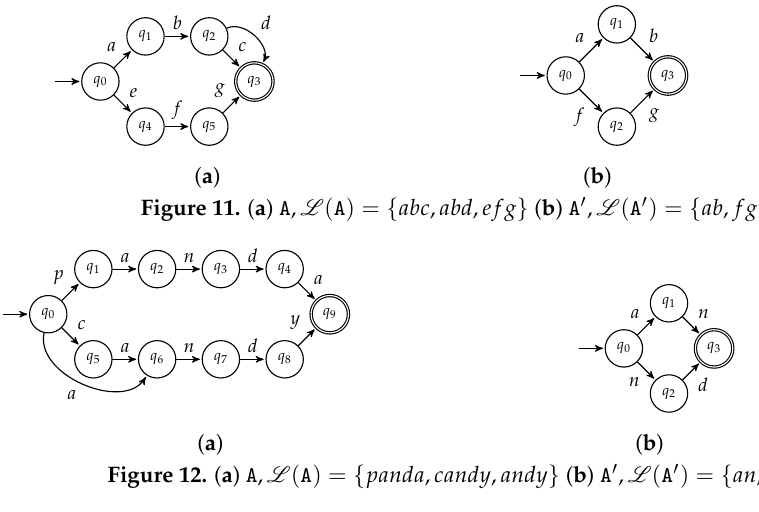
Figure 12. ( a ) A , L ( A ) = { panda , candy , andy } ( b ) A (cid:48) , L ( A (cid:48) ) = { an , nd }